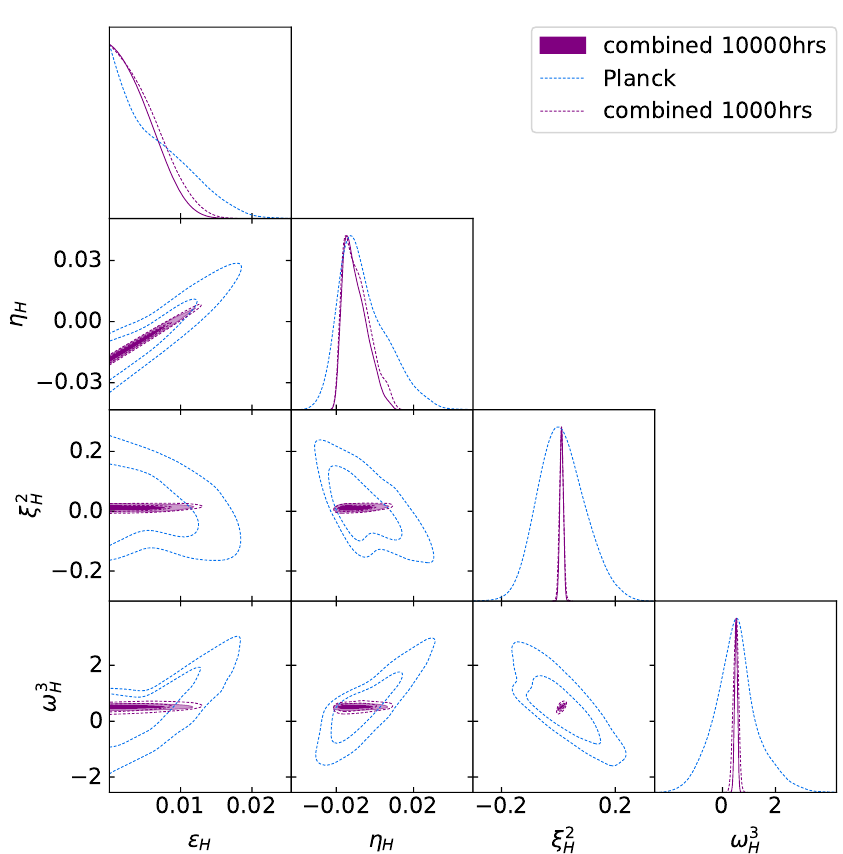
Figure 10: Marginalized 68% and 95% CL contours from the 5-dimensional likeli- hood of the slow-roll parameters in Eq.(14), also marginalized over the cosmological parameters in Eq.(15). We combine the 2018 Planck results with SKA projections assuming 10000 hrs (purple solid) and 1000 hrs (purple dashed) observation time and overlay the Planck contours from Fig.